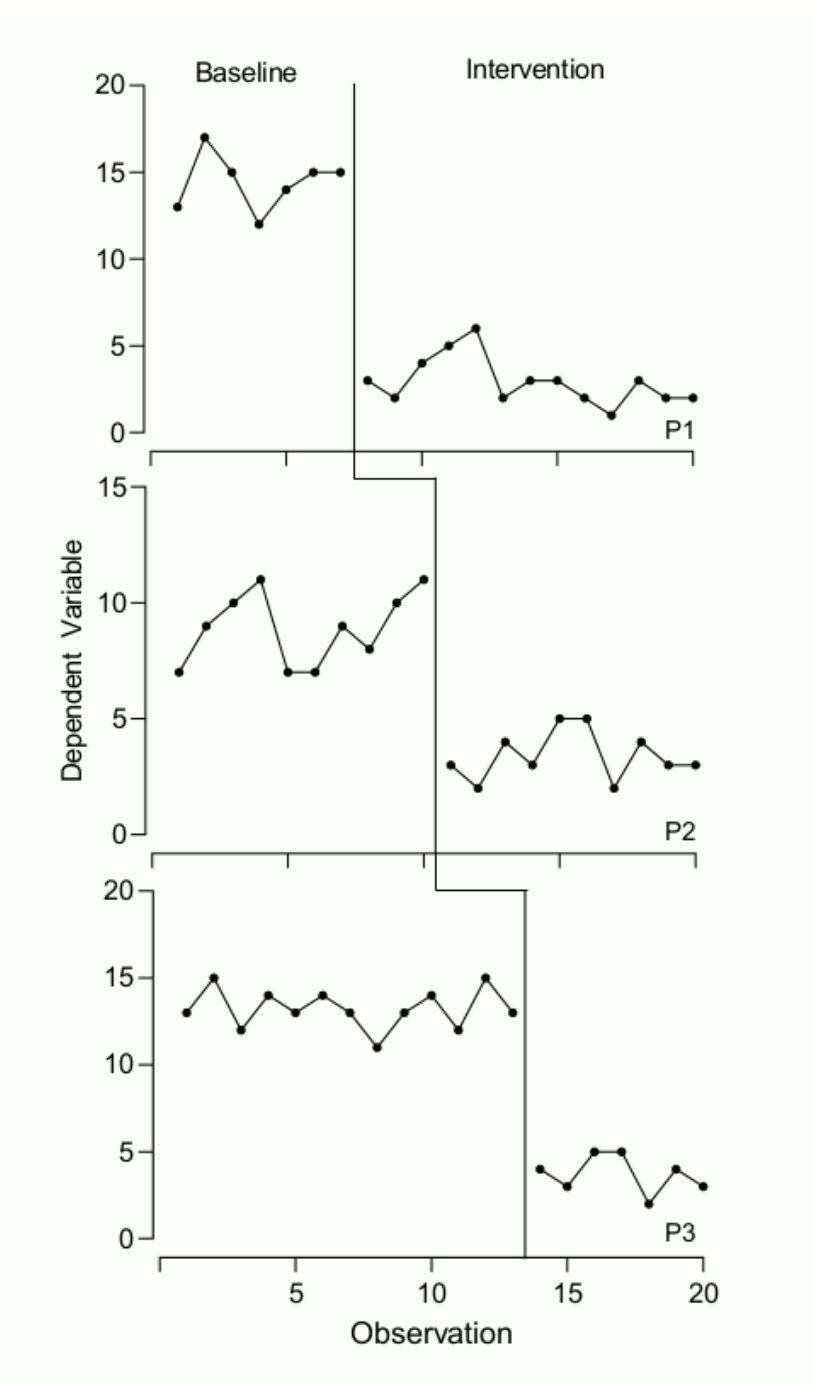
Figure 3. Example of a multiple baseline design showing replications between subjects. P1–P3 represent different hypothetical